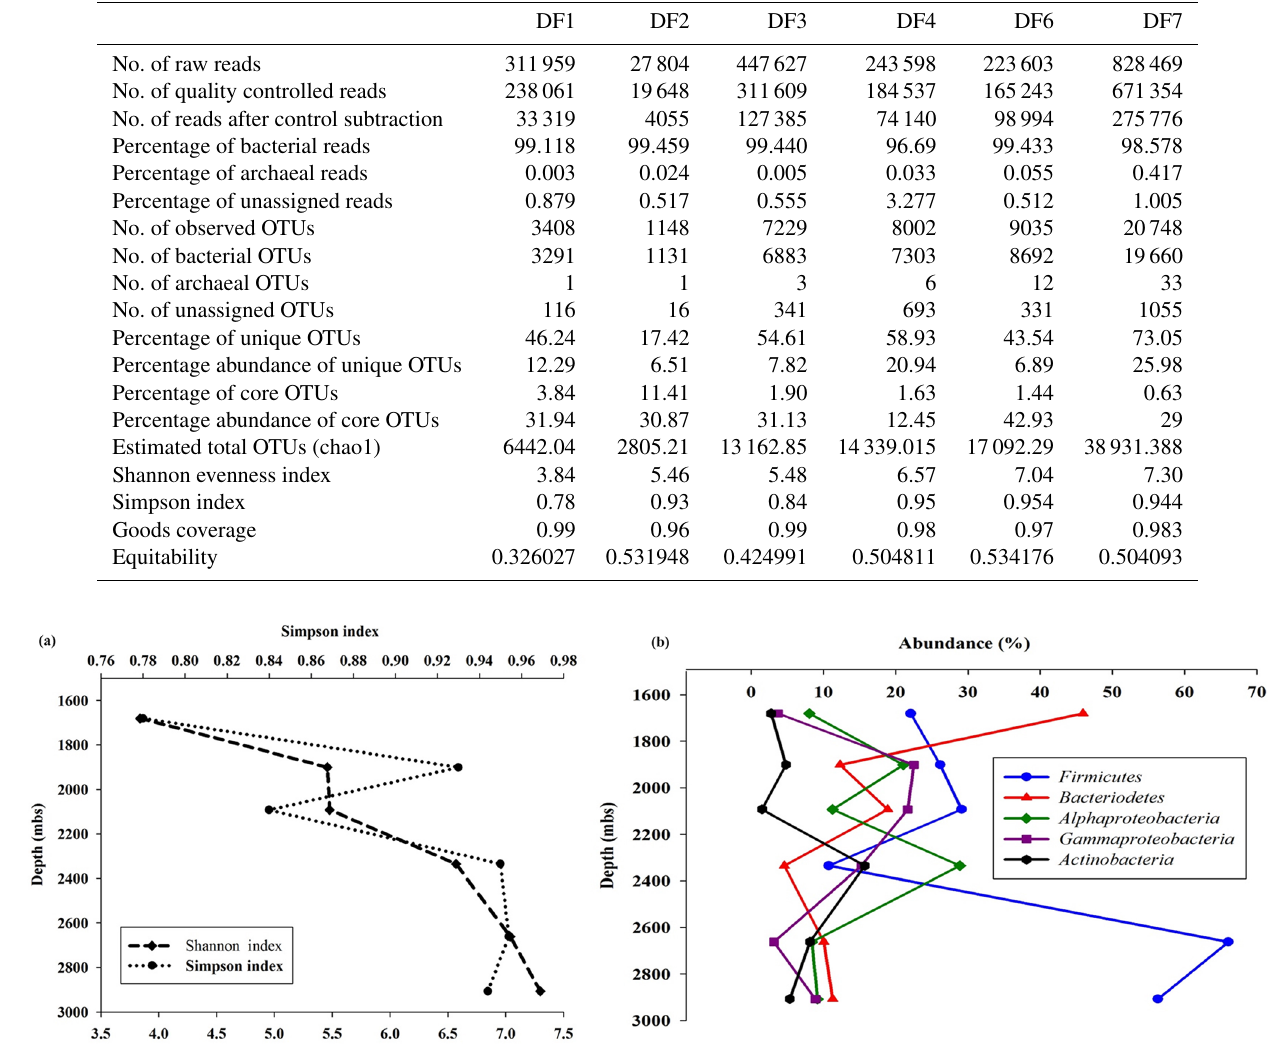
Table 1. Read details and alpha diversity.